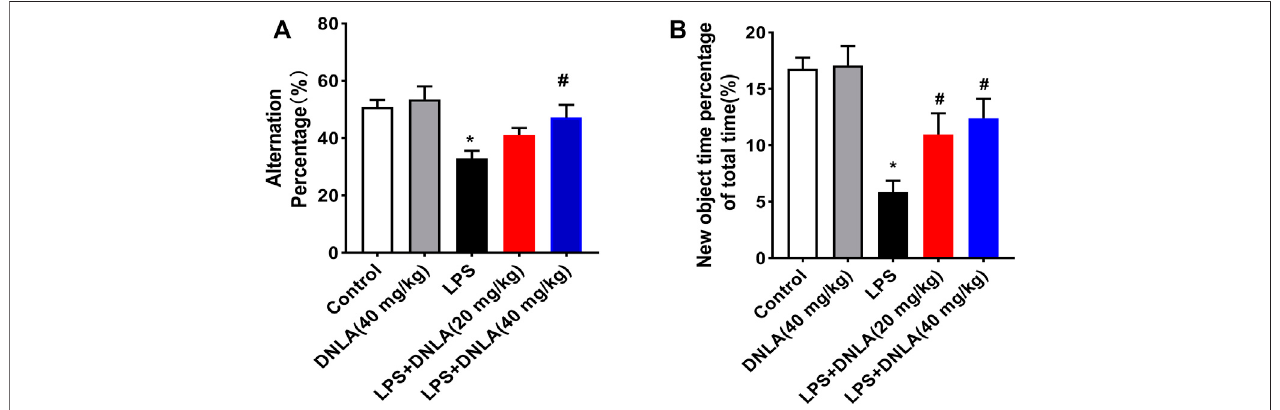
FIGURE 1 | DNLA ameliorated LPS-induced spatial learning and memory function. Wild-type mice were given DNLA (20 or 40 mg/kg) intragastrically for 14 consecutive days. On the seventh day, after DNLA treatment, mice received single intranigral injection of LPS (2 μ g) on both sides of the hippocampus. After DNLA for 10 days,theY-mazetest (A) andnovelobjectrecognitiontest (B) wereperformed.* p < 0.05comparedwiththecontrolgroup, # p < 0.05comparedwiththeLPS-treated group. Results were expressed as mean ± SEM, n = 10.